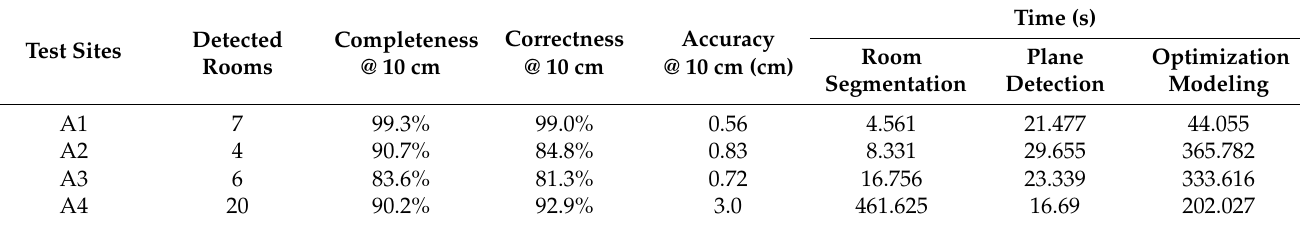
Figure 8. Completeness, correctness, and accuracy of each reconstructed polygon model. Table 4. The evaluation results for point cloud